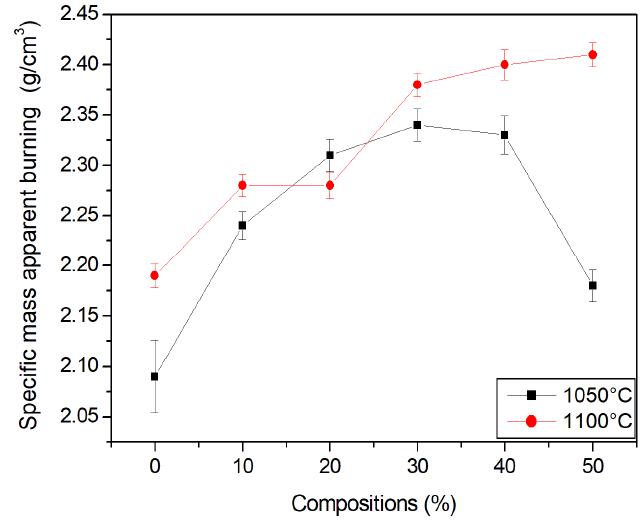
Figure 8. Specific mass apparent burning of the compositions.